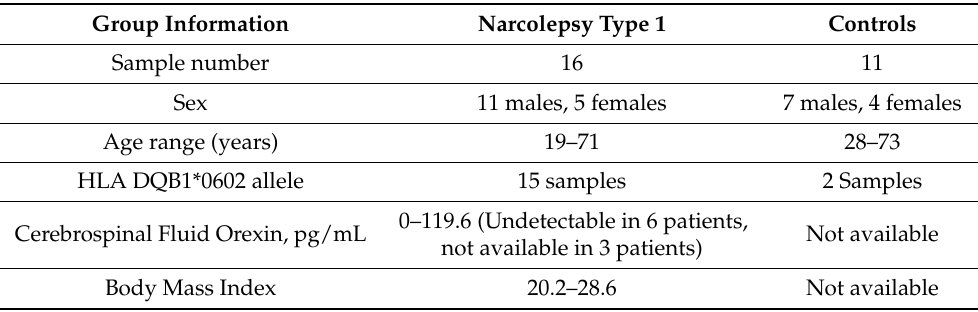
Table 1. Specifications of human study